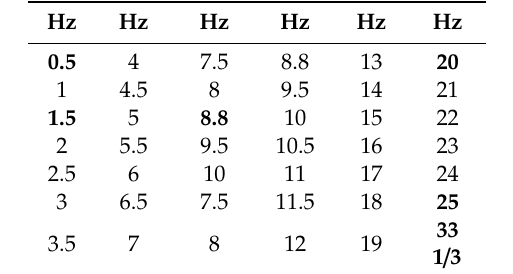
Table 1. Flickermeter mandatory (bold printed) and optional modulation frequencies for sinusoidal fluctuations